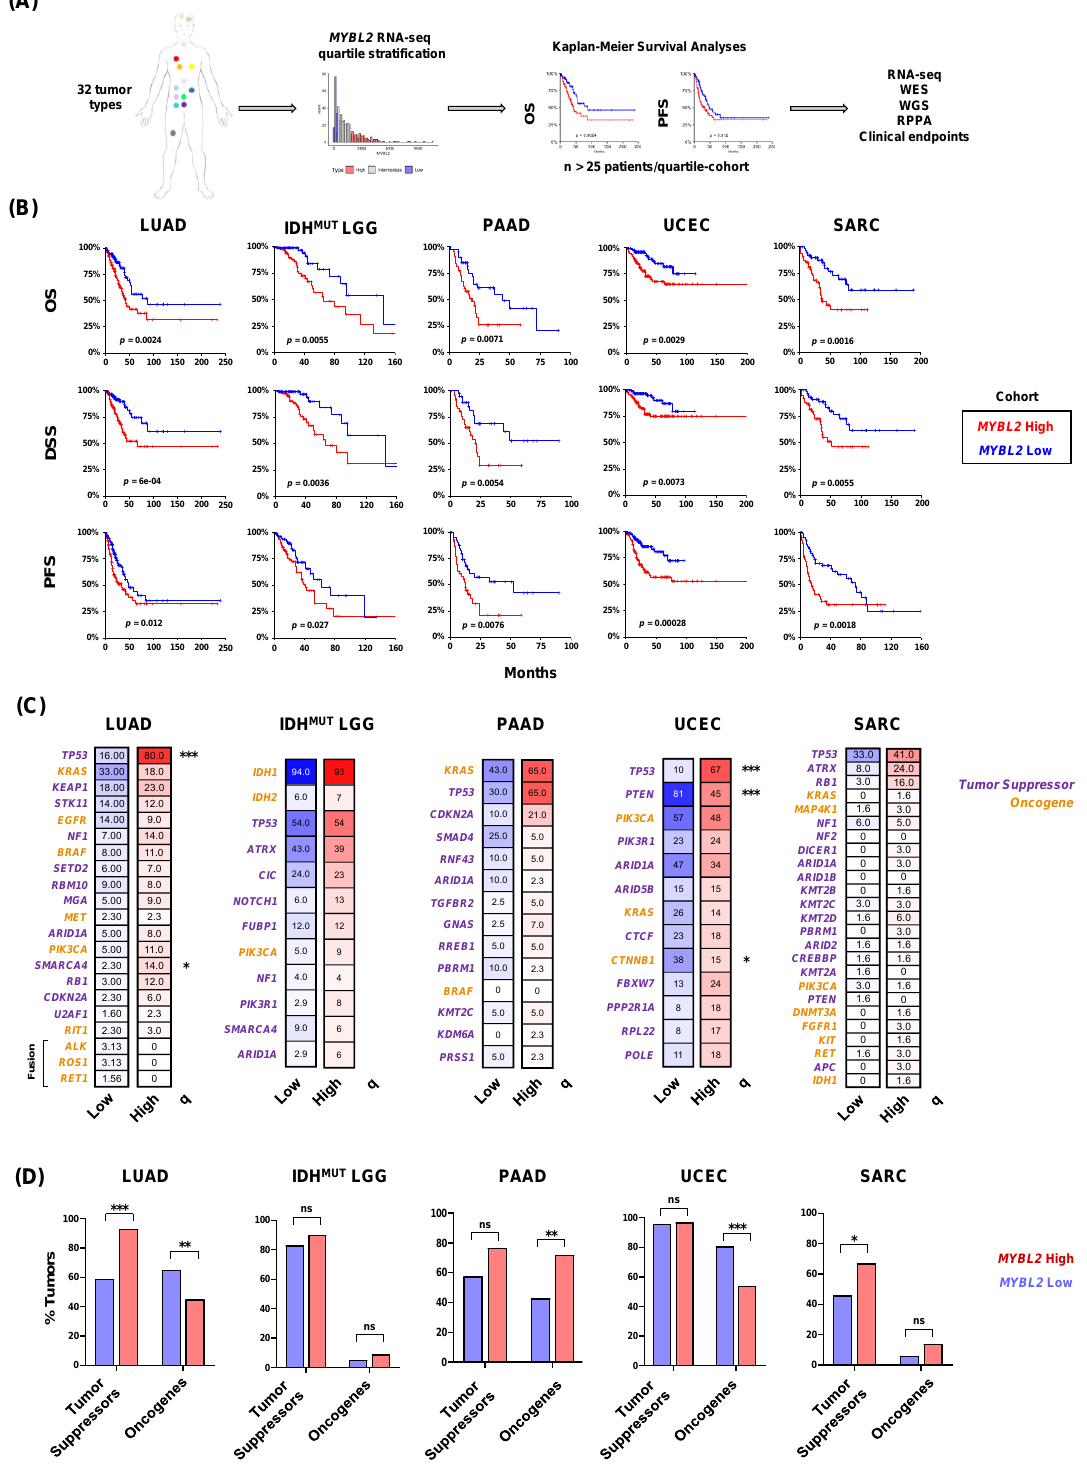
Figure 1. Elevated MYBL2 mRNA expression identifies patients with poor outcomes across mul- tiple tumor types and genotypes. ( A ) Pan-cancer analysis overview. ( B ) Kaplan-Meier analyses demonstrate that MYBL2 expression is robustly prognostic across multiple tumor types for OS,